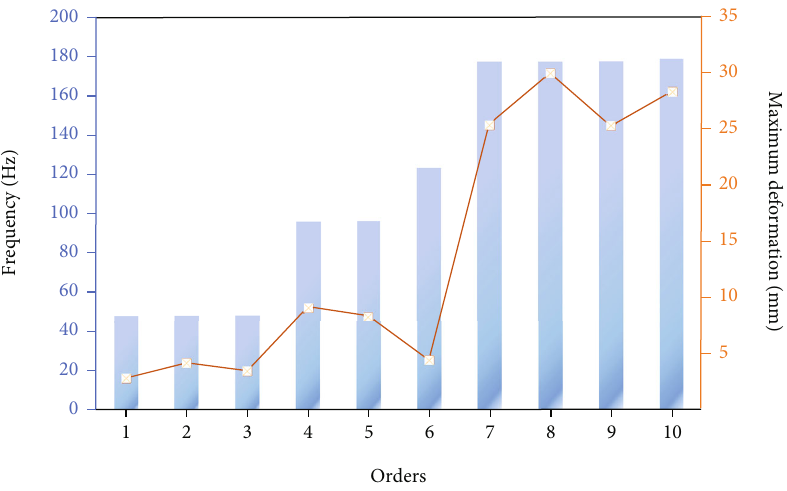
Figure 22: Natural frequencies and the biggest deformation of adjusting